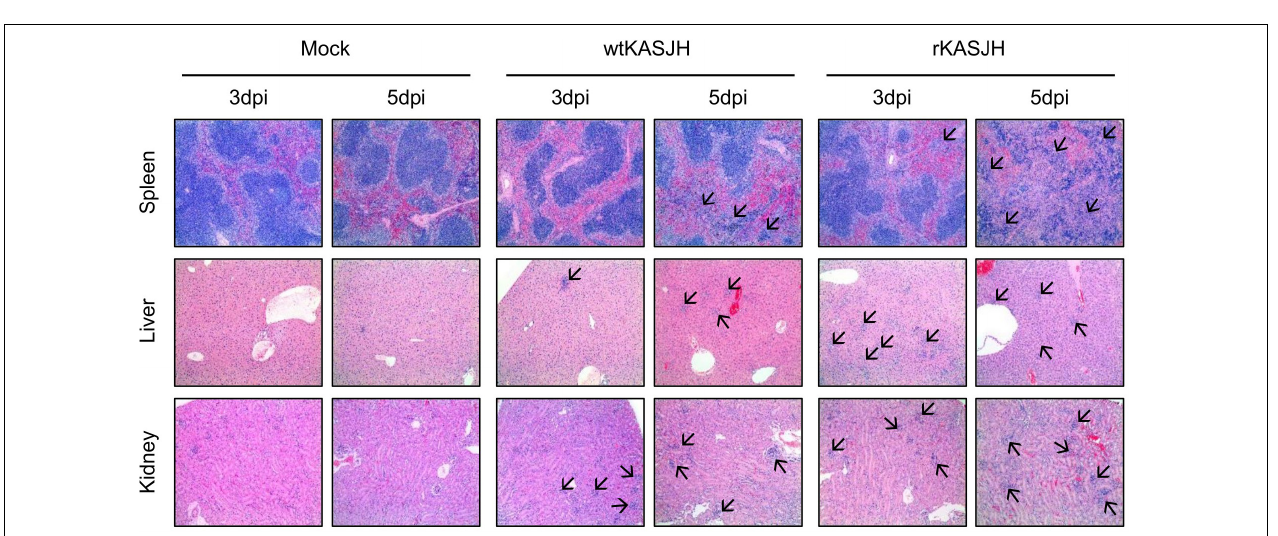
FIGURE 4 | Viral RNA copy numbers and titers in serum (A,C) and tissues (B,D) from C57BL/6 IFNAR − / − mice infected with parental and recombinant SFTSVs. Samples were collected at 1, 3, and 5 dpi. Copy numbers and titers were determined by real-time qRT-PCR and focus-forming assays, respectively. Data are represented as the mean ± s.d. Significance was determined by 2-way ANOVA with Tukey’s multiple comparisons test. * p < 0.05; ** p < 0.01; *** p < 0.001; **** p < 0.0001.